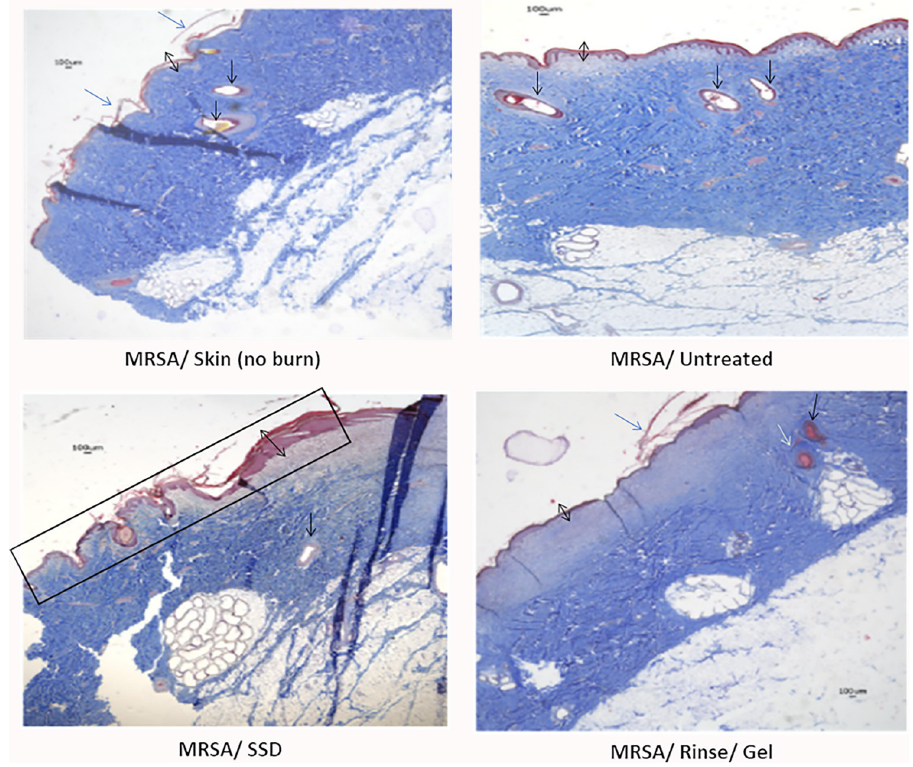
Fig 6. Comparative histological images reveal the difference in healing, between MRSA-infected PTBWs treated with wound rinse and wound gel or with silver sulfadiazine (SSD) compared to the untreated wound burns. Skin biopsies of burn wounds from day 28 were subjected to the Masson’s trichrome staining. Masson trichrome staining highlights collagen content (blue). The black double headed arrow represents the thickness of epidermis, the single headed blue arrow shows the keratinized zone of skin, the single headed white arrow shows follicles, the single headed black arrow projects the sebaceous gland, and the black box shows the damage to collagen by the burn that remains unhealed in SSD treated samples. The pictures show thicker collagen fiber pattern, even epithelial thickness, and decreased epithelial cell density (MRSA/Rinse/Gel) in the intervention burn, compared to the control images.